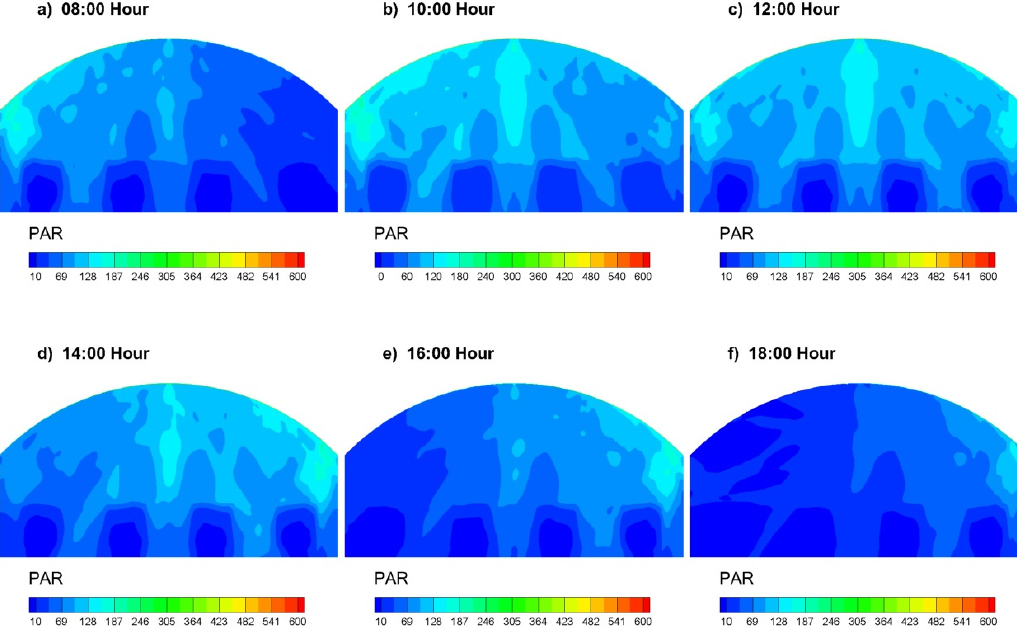
Figure 5. PAR isocontours for 21 June and τ n,PAR =60%.